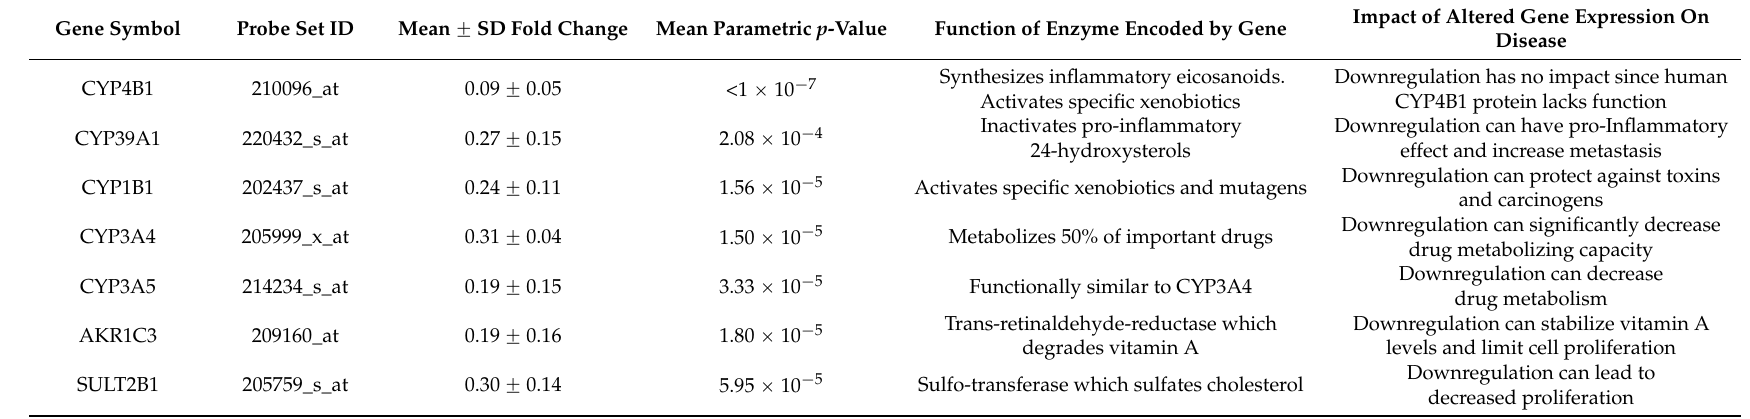
Table 3. Differentially Expressed Genes in Primary Melanomas versus Normal Skin. Mean Fold change and p -values for each gene were calculated from at least 2 of the 3 melanoma datasets. Five CYP450 genes and AKR1C3 and SULT2B1 genes were 3-11 fold downregulated in primary melanomas versus normal